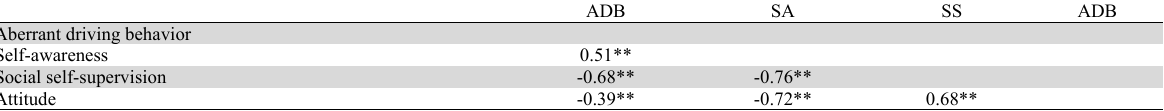
The bivariate correlation between attitude (A), social self-supervision (SS), self-awareness (SA), and aberrant driving behav- ior (ADB)